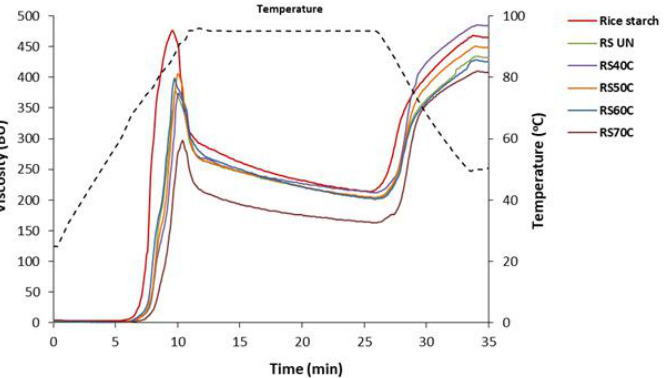
Figure 6. Pasting curves of native rice starch and resistant starches (RS) isolated from rice bran that was untreated (UN) and ultrasonicated (1.8 W/cm 2 , 20 min) at different temperatures. BU: Brabender units.